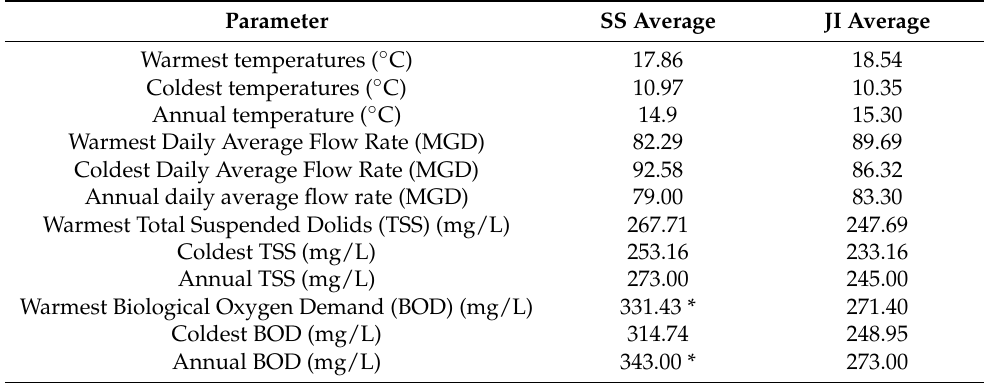
Table 1. Comparison of JI and SS parameters across all samples ( n = 186), and in warmest ( n = 70) versus coldest ( n = 38) months. Samples were collected from an automated samplers at MMSD reclamation facility, aliquots were removed by WWTP